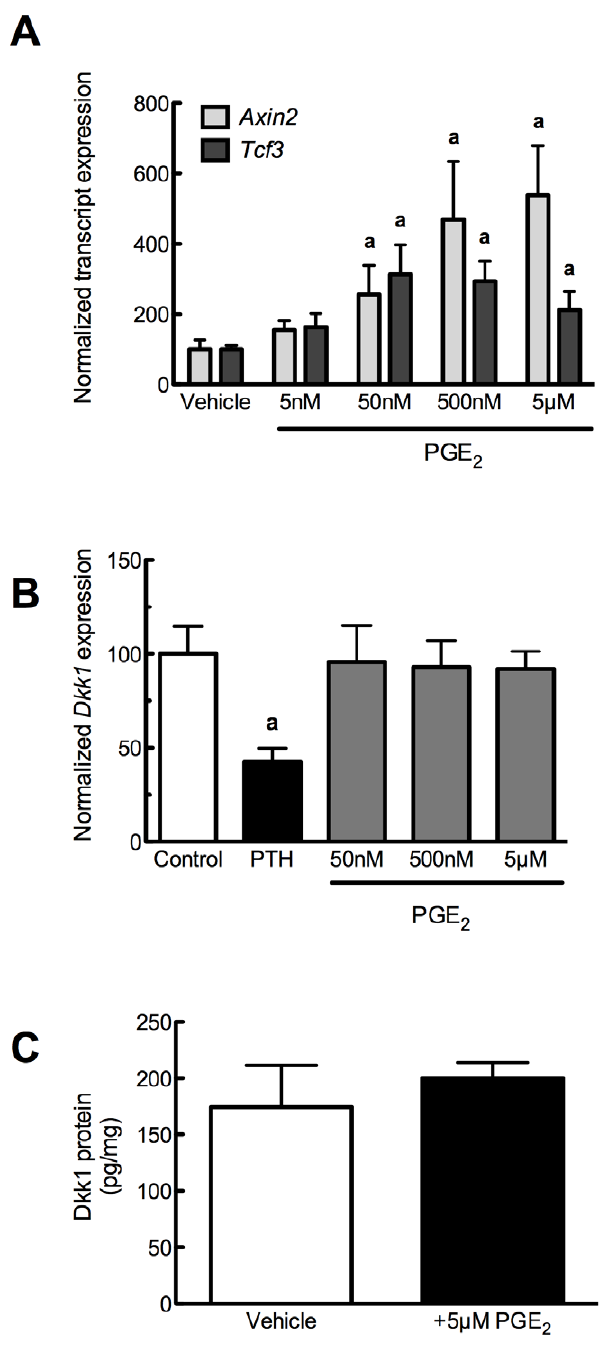
Figure 2. PGE 2 increases Wnt signaling without affecting Dkk1 . ( A ) PGE 2 (5 nM–5 m M) or vehicle control (0.05% DMSO) was added to UMR 106.01 cells for 24 hours. Total RNA was collected and analyzed for Axin2 , Tcf3 , and Rpl32 expression by qPCR. n=4 samples. Compared to vehicle control, a indicates p , 0.05. ( B ) Human PTH(1–34) (100 nM) or PGE 2 (50 nM–5 m M) or vehicle control (0.05% DMSO) was added to UMR 106.01 cells for 3 hours. Total RNA was collected and analyzed for Dkk1 and Rpl32 expression by qPCR. n=8 samples. Compared to vehicle control, a indicates p , 0.05.